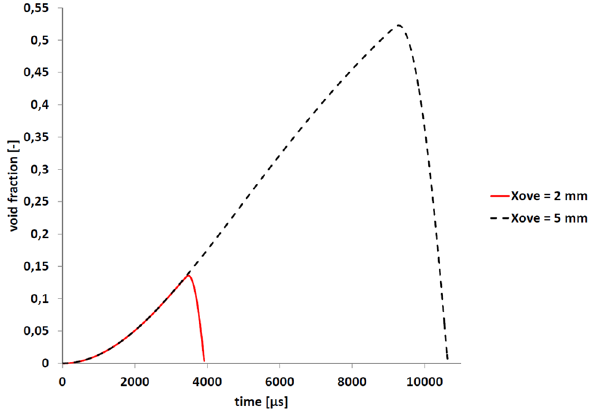
for different values ove = 12 µm and p = 10 gap pump